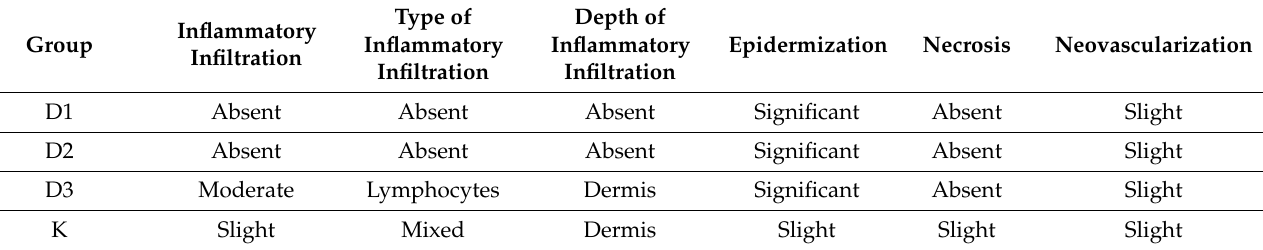
Table 12. Histopathological results from day 25.